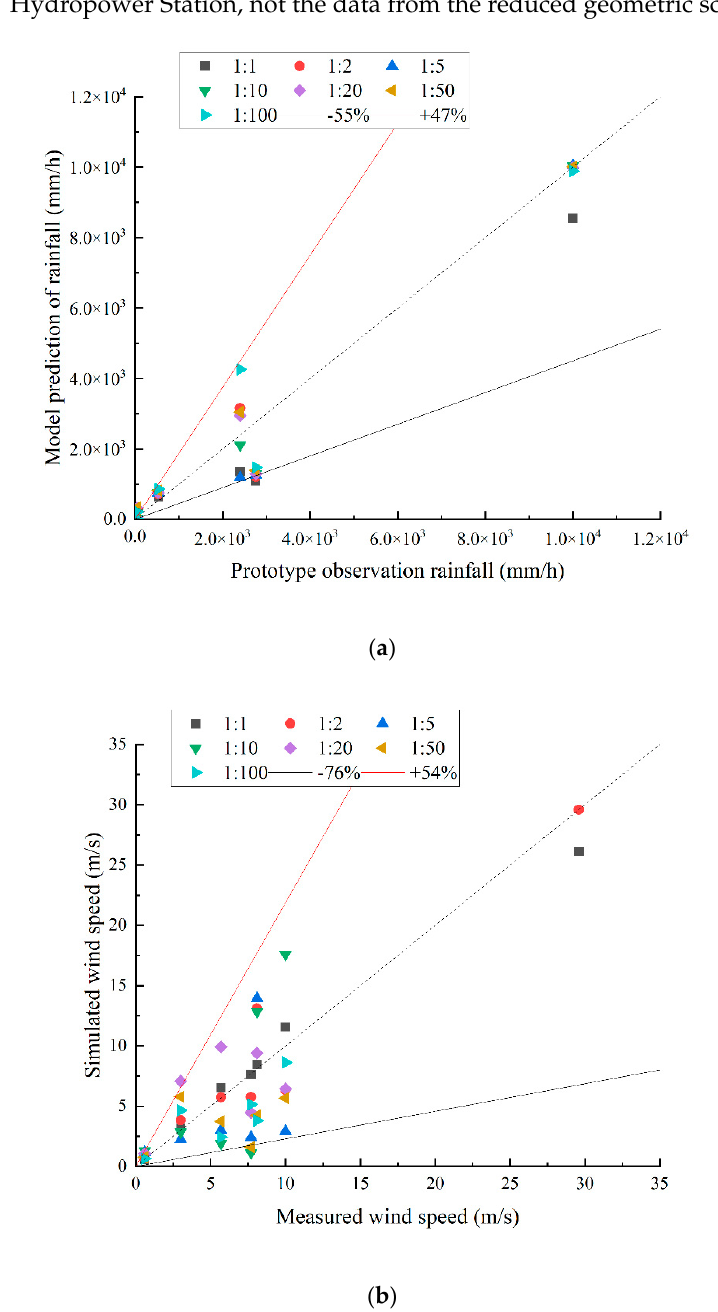
Figure 13. Comparison of simulated rainfall intensity ( a ) and wind speed ( b ) with prototype observations under different geometric scale conditions.